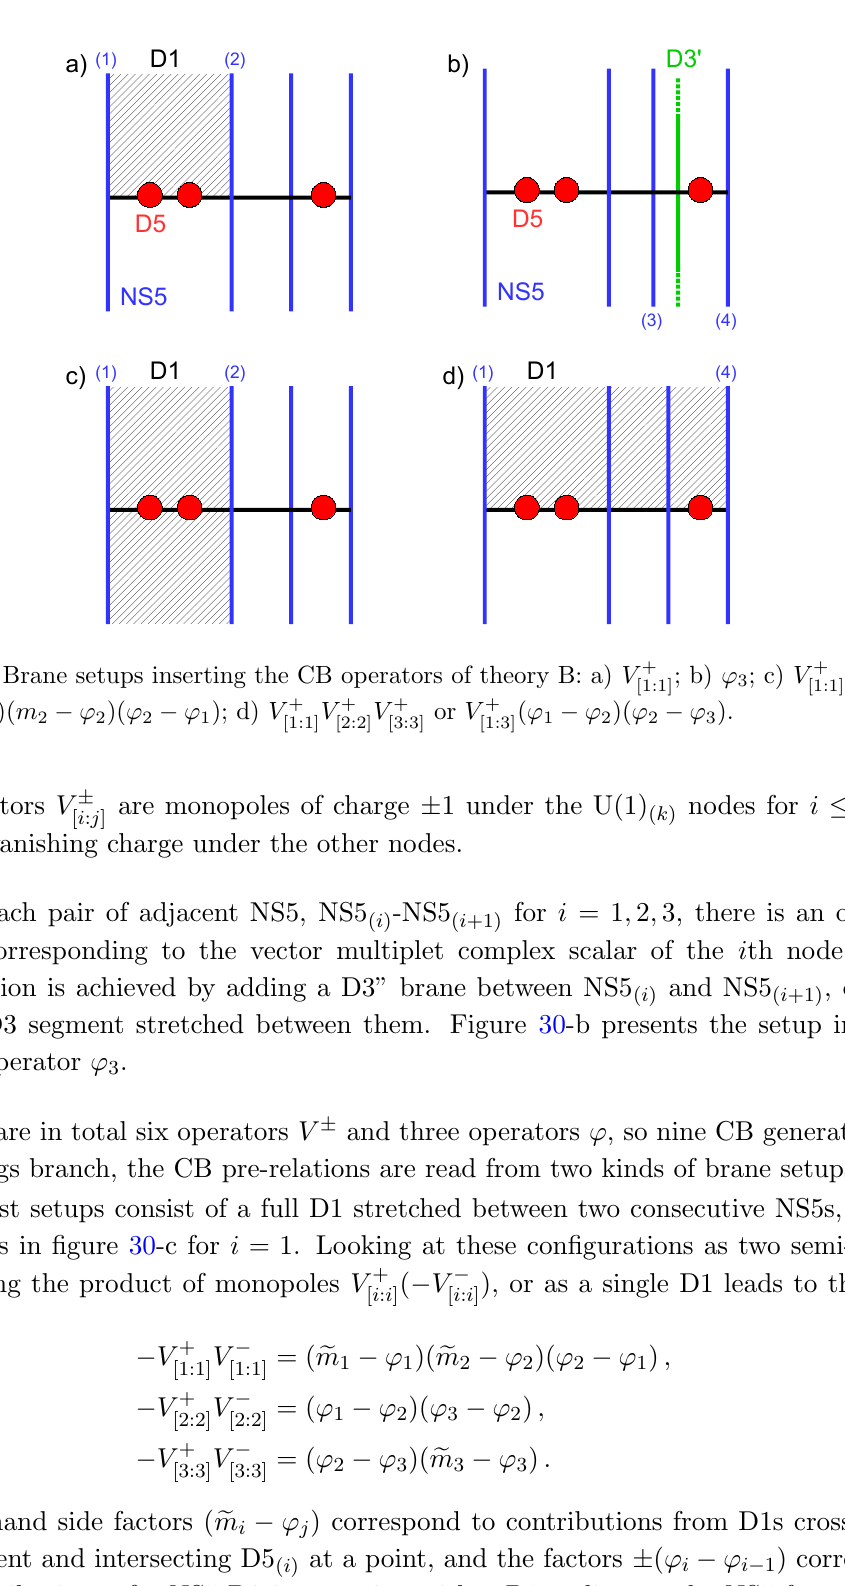
( (cid:0) V (cid:0) ) [1:1] [1:1]